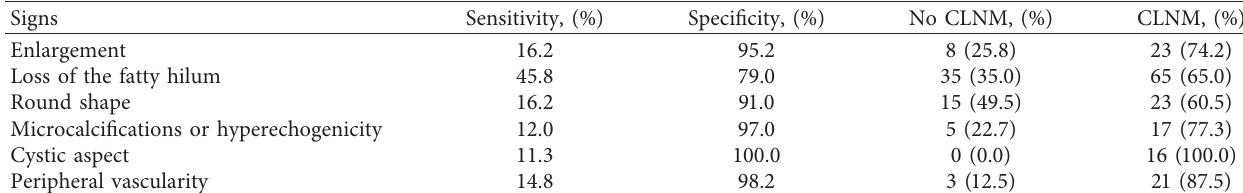
Peripheral vascularity CLNM, central compartment lymph node